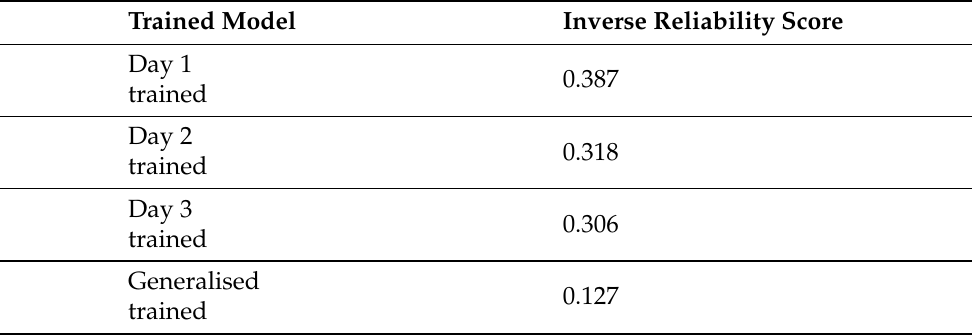
Table 12. Inverse reliability scores for single day training and generalised